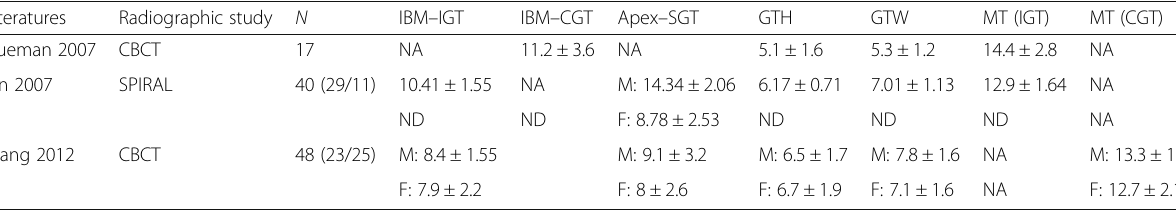
Table 1 Comparison of the measurements for the genial tubercle position evaluated by radiographic measures